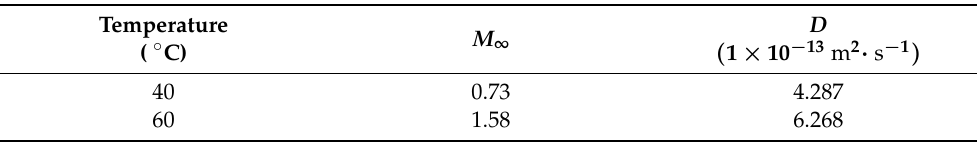
Table 2. Equilibrium water uptake, M ∞ , and diffusion coefficient, D , at the two hygrothermal ageing temperatures used in this